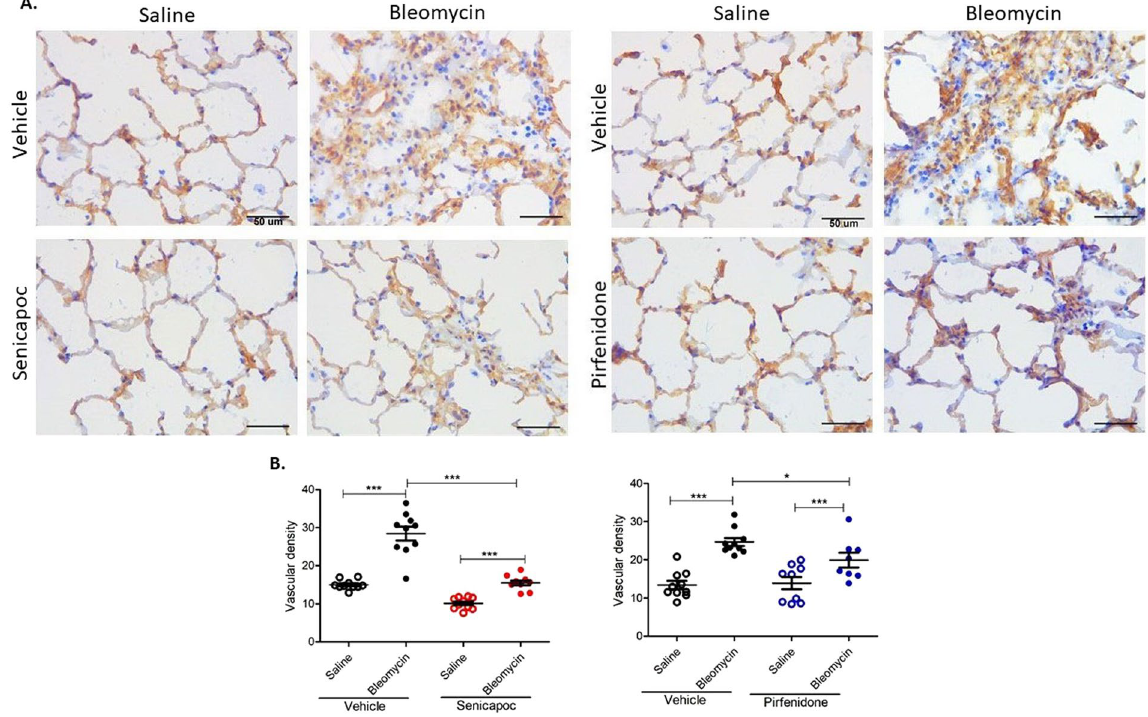
Figure 3. Effects of senicapoc and pirfenidone on remodelling of collagen type IV stained capillaries induced by bleomycin. ( A ) The panels show representative anti-collagen type IV immuno-stained sections of lung segments from sheep that were treated with either vehicle, senicapoc or pirfenidone. The lung segments from individual sheep were infused with either saline (left-side images), or bleomycin (right-side images). ( B ) Shows the vascular density data between the different treatment groups. Vascular density was determined by the percentage of the total area of anti-collagen type IV-positive vascular area per field of lung parenchyma. Ten images were taken from fibroproliferative areas for each lobe from each sheep (n = 10) and the values for each of the ten images were averaged for each lobe. Data show individual values plus mean. Significance was determined using a paired t test between lobes from the same treatment group and an unpaired t test between lobes from different groups, * p < 0.05, *** p < 0.001. Data represent mean ( ± SEM). Scale bars = 50 µ